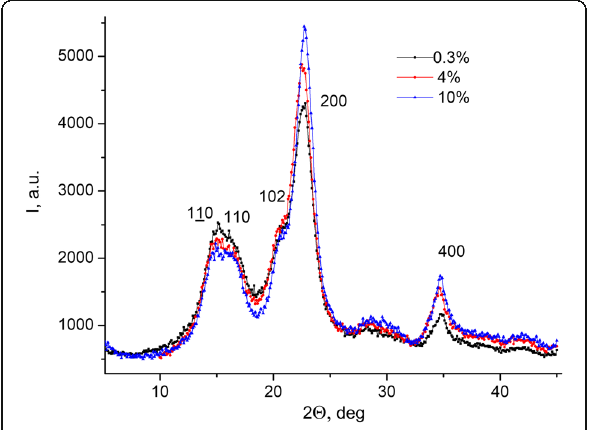
Fig. 6 Dependencies of intensity of diffracted X-ray radiation for MCC. Dependencies of intensity of diffracted X-ray radiation for MCC with different water concentrations on the diffraction angle I (2 θ